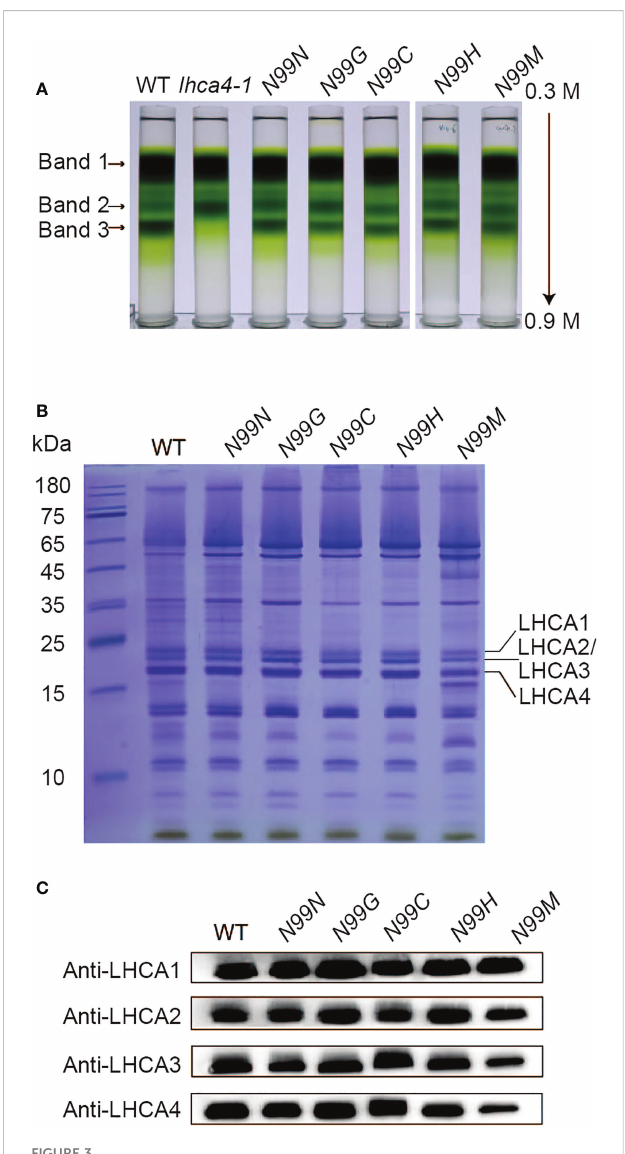
FIGURE 3 Isolation and characterization of PSI-LHCI from N99 point mutant lines. (A) Sucrose density gradient ultracentrifugation of detergent- treated thylakoid membranes isolated from the WT, lhca4-1 , the control, and N99 point mutant lines. The lowest band, labeled Band 3, was collected and analyzed. (B-C) Polypeptide composition of Band 3 as analyzed by Coomassie staining after SDS-PAGE (samples corresponding to 2.5 m g Chl were loaded per lane). (B) and immunoblot analysis with antibodies against LHCA1, LHCA2, LHCA3, and LHCA4 (C)